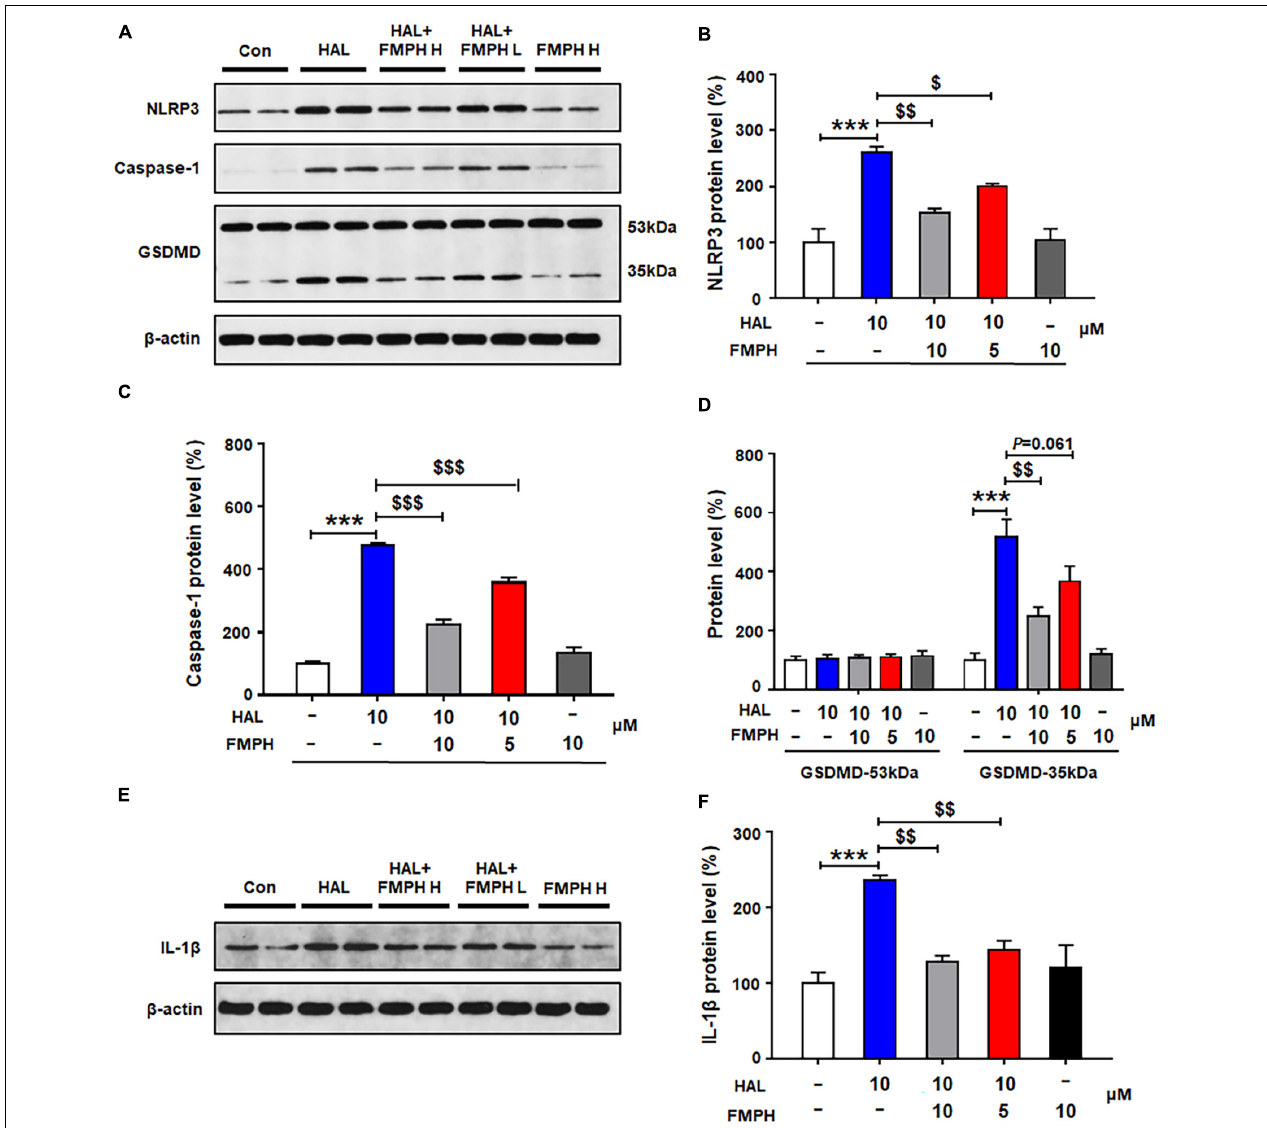
FIGURE 9 | Co-treatment with 2-(3-trifluoromethylphenyl) histamine (FMPH) suppressed haloperidol-induced activation of NLRP3/caspase-1 and inhibited IL-1 β protein expression in cultured astrocytes. (A–F) Cultured cells were treated with vehicle [dimethyl sulfoxide (DMSO) + water], haloperidol 10 µ M, haloperidol 10 µ M + FMPH 10 µ M, haloperidol 10 µ M + FMPH 5 µ M, or FMPH 10 µ M for 24 h. Western blot was used to investigate the expression of NLRP3, caspase-1 (20 kDa), GSDMD (53 and 35 kDa), and IL-1 β . The data are presented as mean ± standard error of the mean. *** p < 0.001 vs. Con; $ p < 0.05, $$ p <